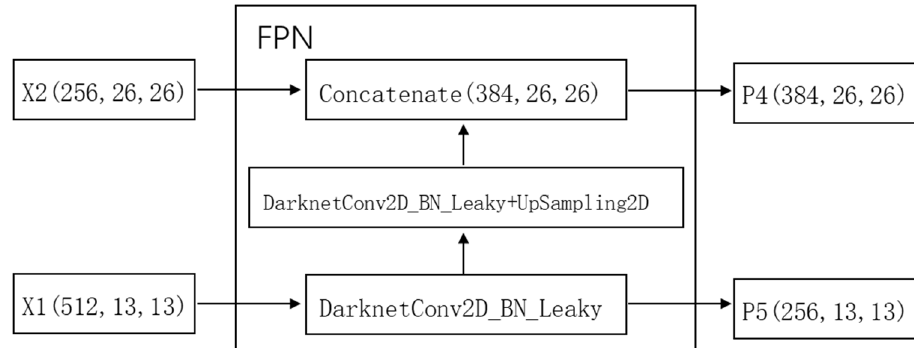
Figure 2. FPN network structure in YOLOv4-tiny.